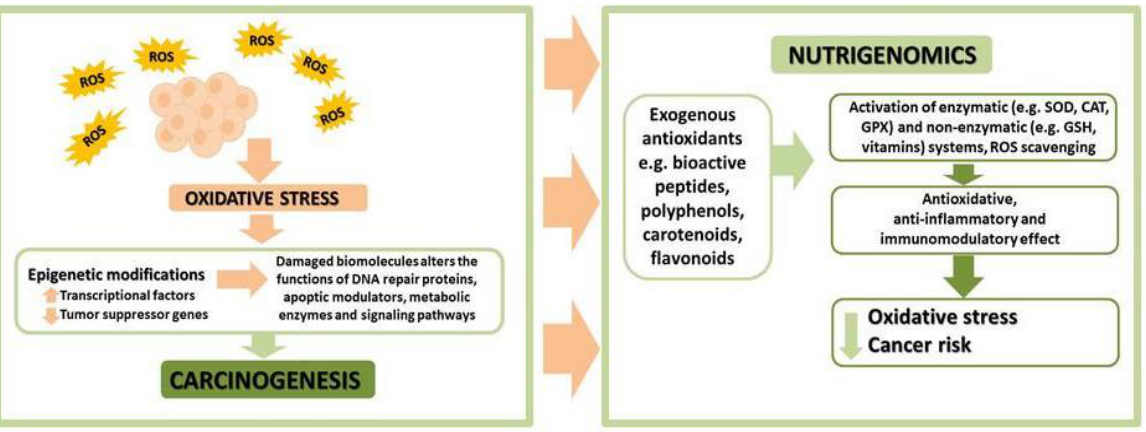
Figure 5. The role of oxidative stress in cancer and the influence of food components on the occurrence of oxidative stress. ROS — reactive oxygen species